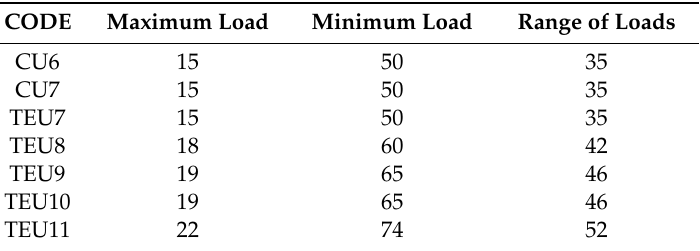
Table 1. Cyclic loads applied on each specimen (kN).